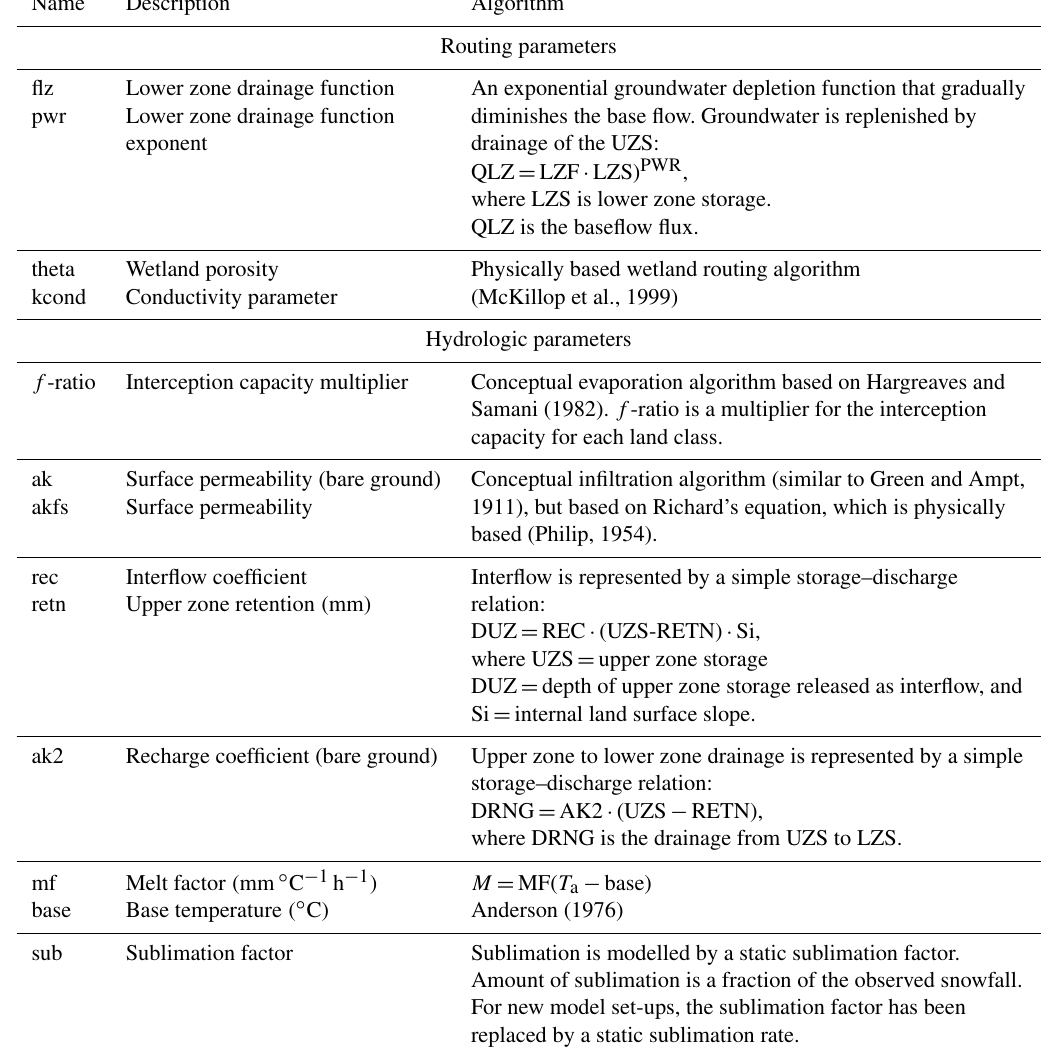
Table 4. Parameters included in the Monte Carlo calibration, alongside a description of what the parameter represents and the algorithm it is used